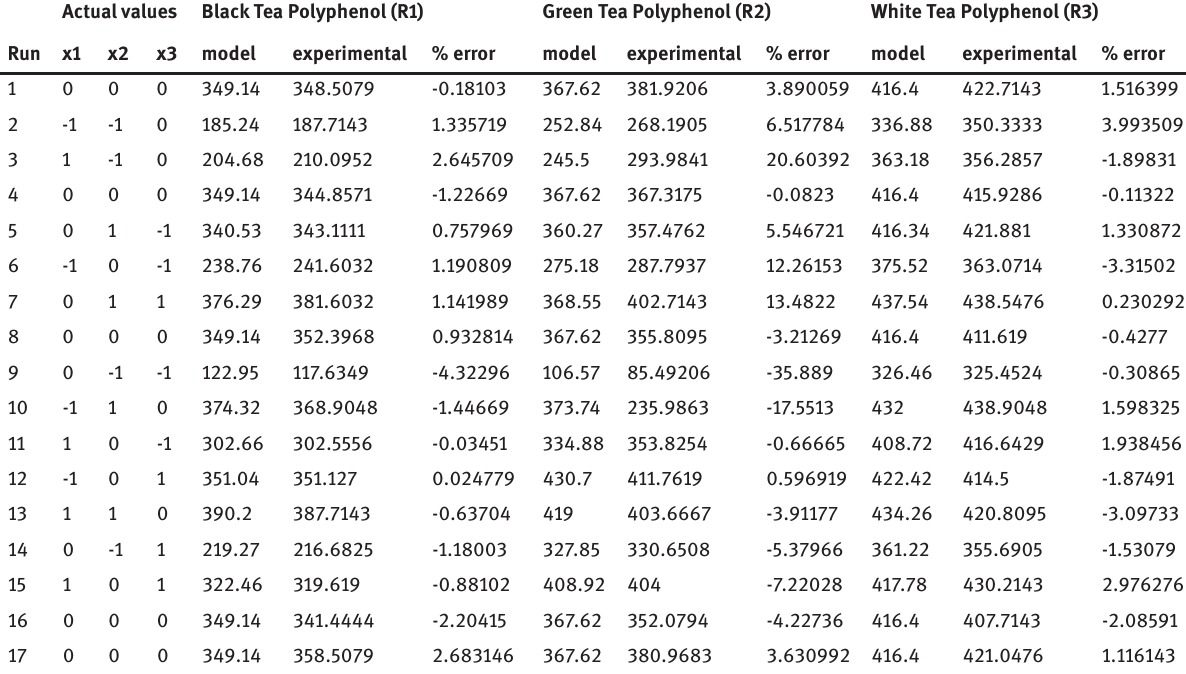
Table 1: Box-Behnken design matrix containing experimental and model values of total polyphenol content (mg gallic acid/mL) of black, green and white tea.